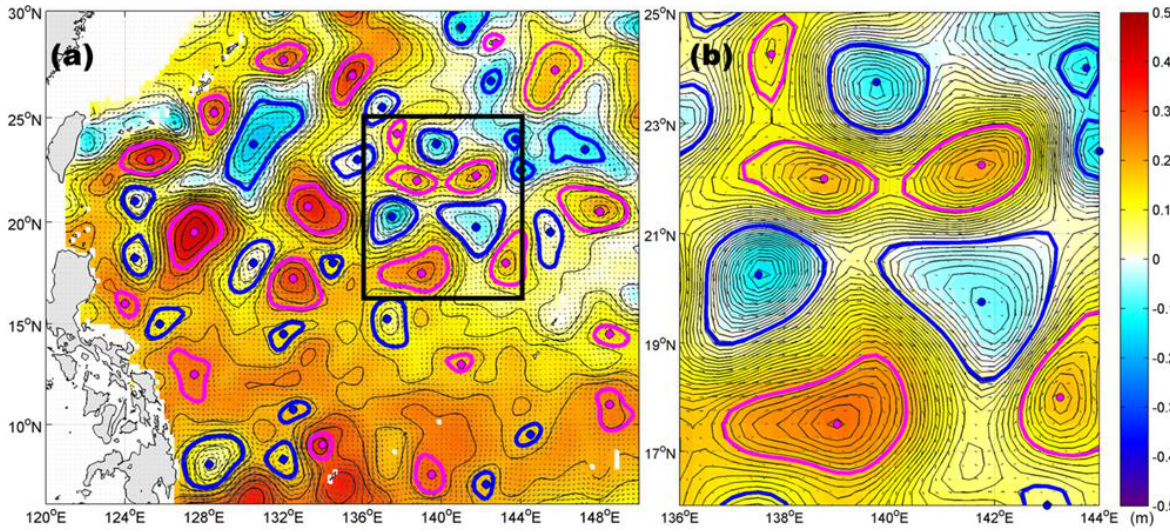
Figure 2. Sea level anomaly (SLA) and eddies on 14 July 2010. Red and blue dots are the centers of anticyclonic and cyclonic eddies, respectively. The eddy edges are enclosed by red (blue) lines. ( a ) Continuous contour lines are displayed every 4 cm; ( b ) Zoom in of the region of black box in (a). Continuous contour lines are displayed every 1